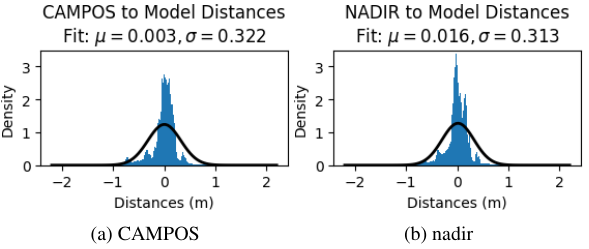
Figure 9. Density histograms along the Gaussian distribution fits of distances between the original model and the dense point clouds generated from each survey method.